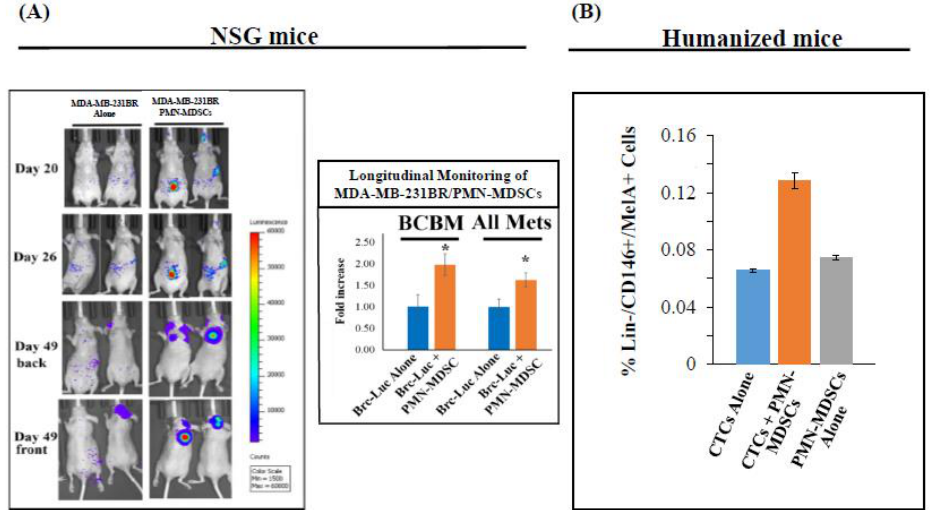
Figure 3. Metastatic competence of CTCs is significantly enhanced by co-transplantation of PMN-MDSCs isolated from the same patient in animals. ( A ) Representative images of mice injected intracardiacally with luciferase-labeled MDA-MB-231BR cells (Brc-Luc) cells, either alone or with unlabeled PMN-MDSCs (1.0 × 10 3 Brc-Luc cells vs. 5.0 × 10 5 PMN-MDSCs), followed by bioluminescence imaging at indicated times. Bioluminescence measurements of metastasis/BCBM per treatment of mice populations ( n = 10 / subgroup; * p < 0.05). ( B ) Detection of FACS-selected patient-derived CTCs (Lin − / DAPI +/ CD146 +/ MelA + cells) and PMN-MDSCs (Lin-/DAPI+/CD33+/CD15+ cells) obtained from blood of a representative melanoma patient injected in humanized mice, either alone (CTC Alone / PMN-MDSC Alone), or together (CTC + PMN-MDSC) (1.0 × 10 3 CTCs, vs. 5.0 × 10 5 PMN-MDSCs). Data show the percentage of live human melanoma CTCs (Lin−/CD146+/MelA+ cells) isolated from humanized murine blood 22 weeks following cell injection. Data represent the mean ± SD of six independent experiments ( n = 6).